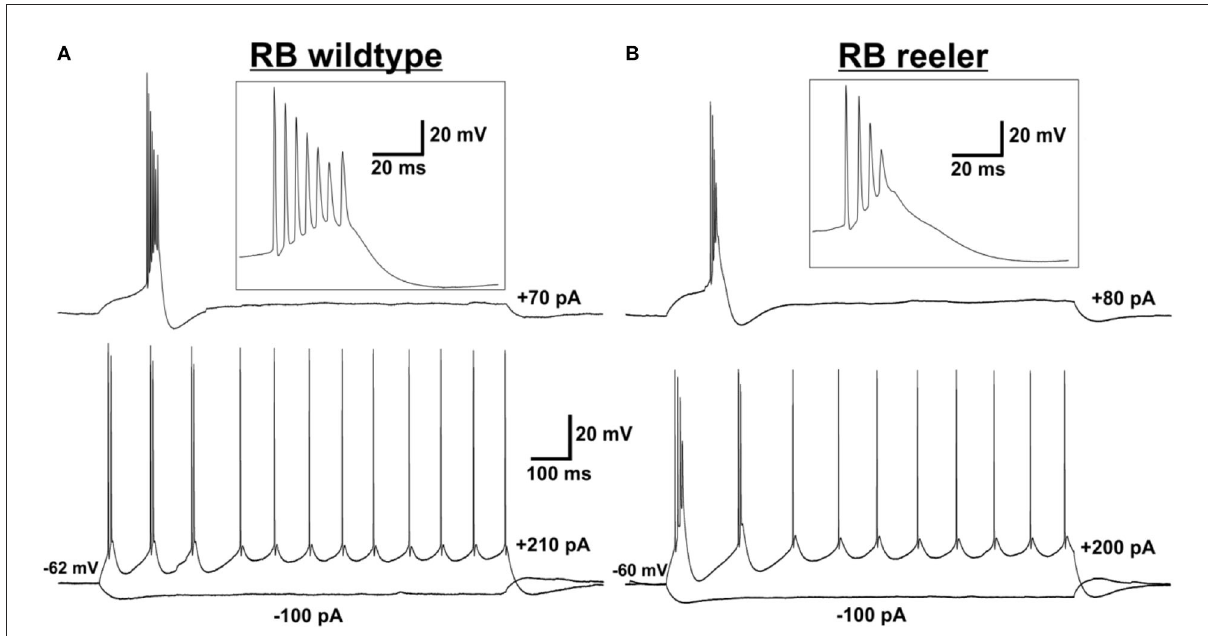
FIGURE1 Electrophysiological characterization of (LVb) repetitively burst-spiking (RB) pyramidal cells. (A,B) Representative examples for RB pyramidal cells in LVb of WT (A) and reeler (B) mice. Voltage responses to rheobase stimulation (upper traces) and to depolarizing suprathreshold and hyperpolarizing stimulation (lower traces). Inserts show the burst at rheobase at higher temporal resolution. (A) Example RB cell of WT mouse firing one burst (with up to 7 APs) at rheobase level and three bursts and several single APs in response to suprathreshold stimulation. Also, a sag is visible after a hyperpolarizing ( − 100pA) stimulus. (B) Example RB cell of reeler mouse firing one burst (with up to 4 APs) at rheobase level and two bursts and several single APs in response to suprathreshold stimulation. A sag is visible after a hyperpolarizing (-100pA)